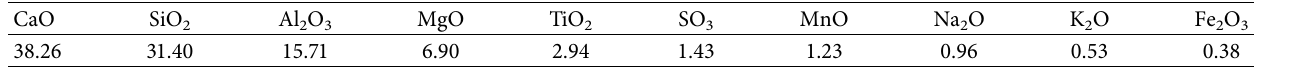
Table 4: Chemical compositions of slag